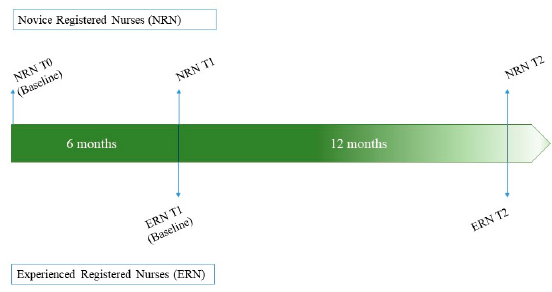
Figure 1. Schematic overview of the Shift Work Nurses’ Health and Turnover (SWNHT) study.